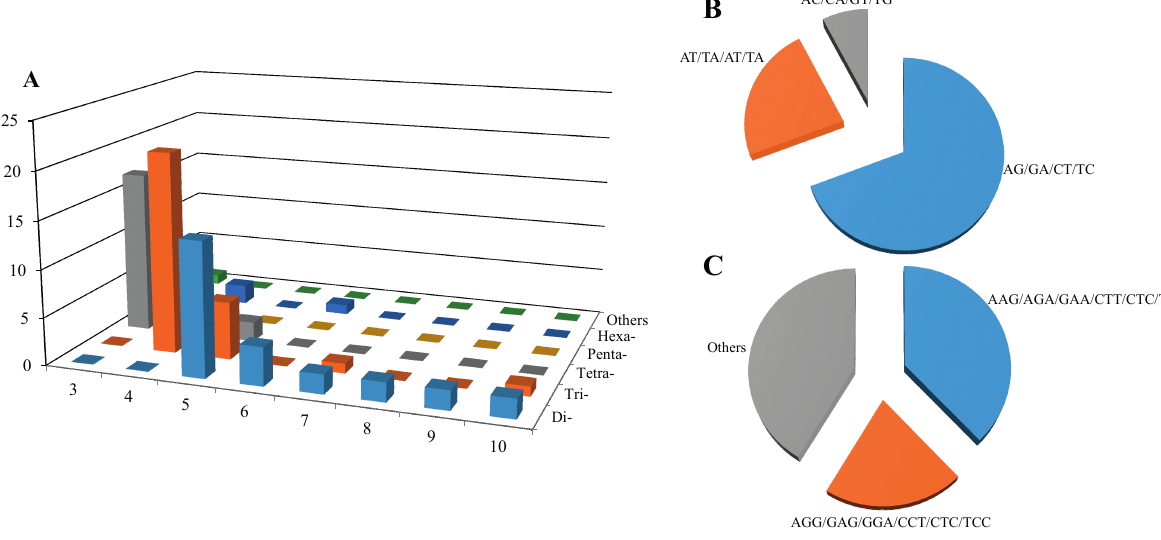
Figure 2. Distribution of SSR motif frequency and typein L. gmelinii 634 EST-SSR unigenes. ( A ) SSR motif type and repeats numbers; ( B ) Percentage of dinucleotide SSR type; ( C ) Percentage of trinucleotide SSR